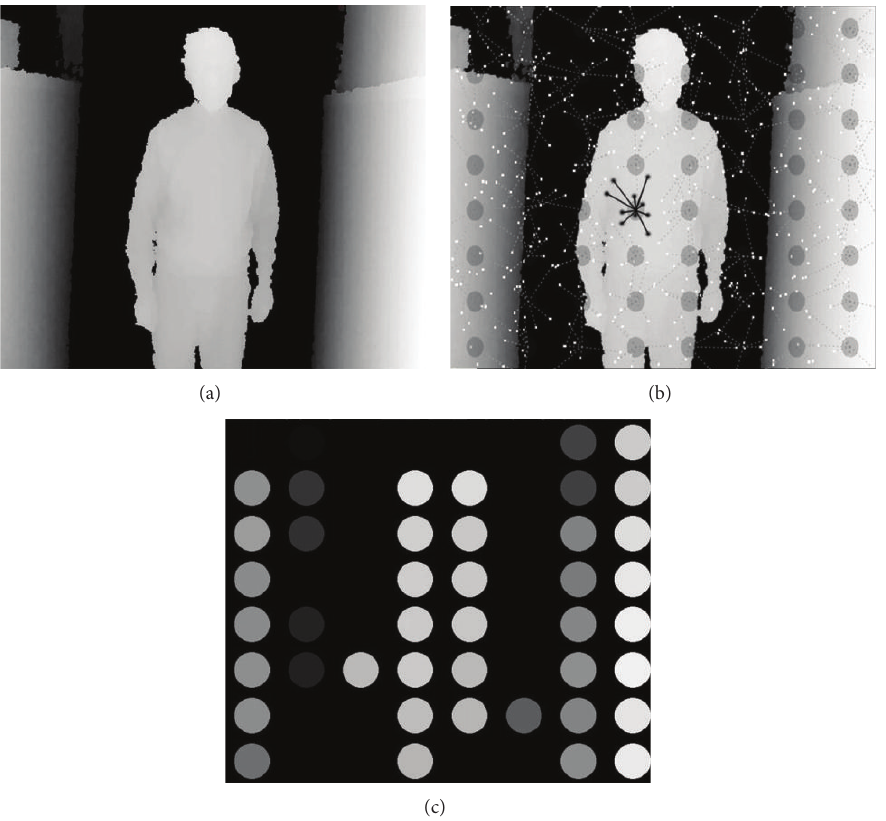
Figure 3: Retinal depth encoder. (a) Grayscale depth map. (b) Activity computation. (c) RF activities: the closer the object, the lighter the